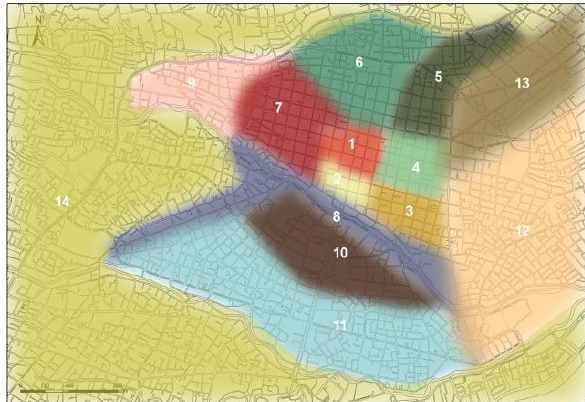
Figure 6. Third division of the unit according to the uses of general and residential services. Source: authors.